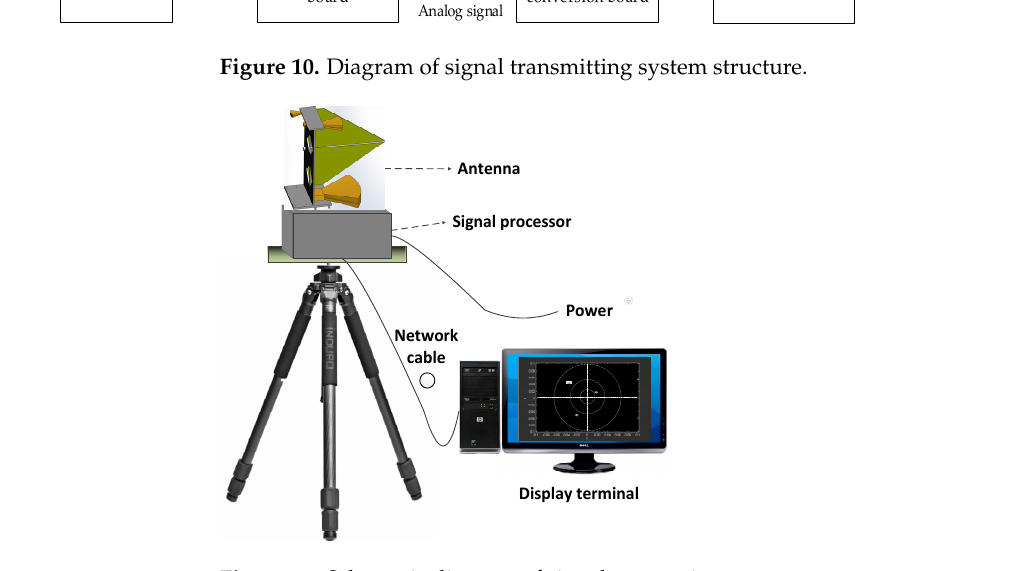
Figure 11. Schematic diagram of signal reconnaissance system.